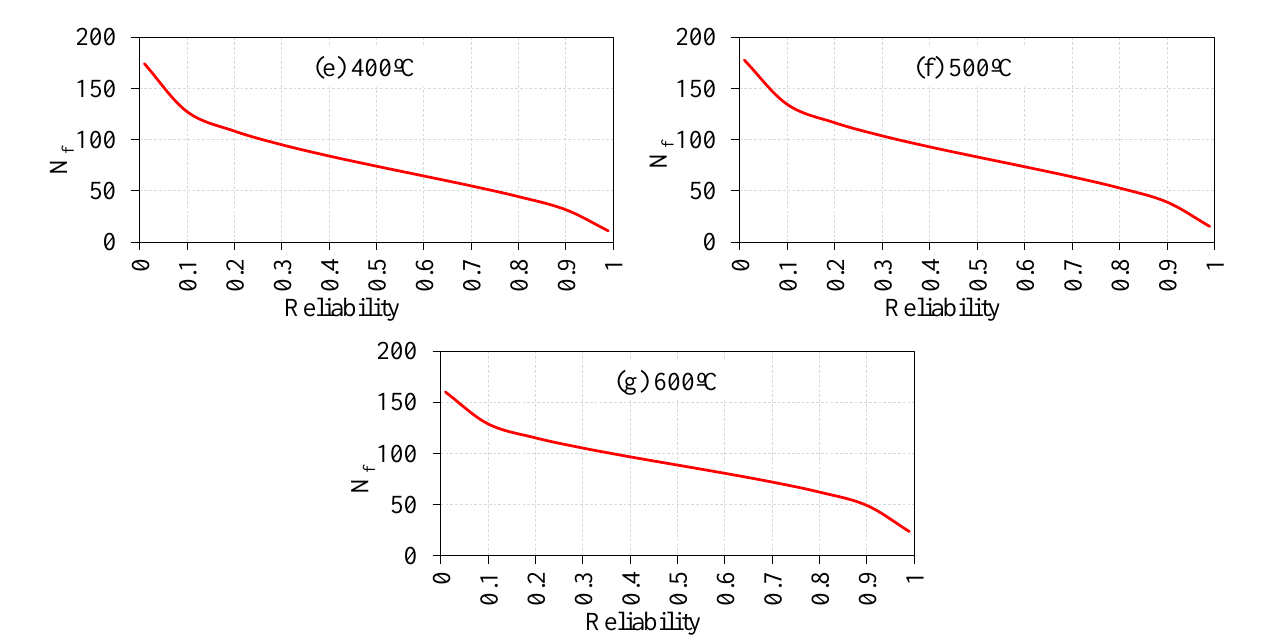
Figure 15. Failure number in terms of reliability ( a ) ambient temperature; ( b ): 100 °C; ( c ): 200 °C; ( d ) 300 °C; ( e ) 400 °C; ( f ) 500 °C; ( g ): 600 °C.